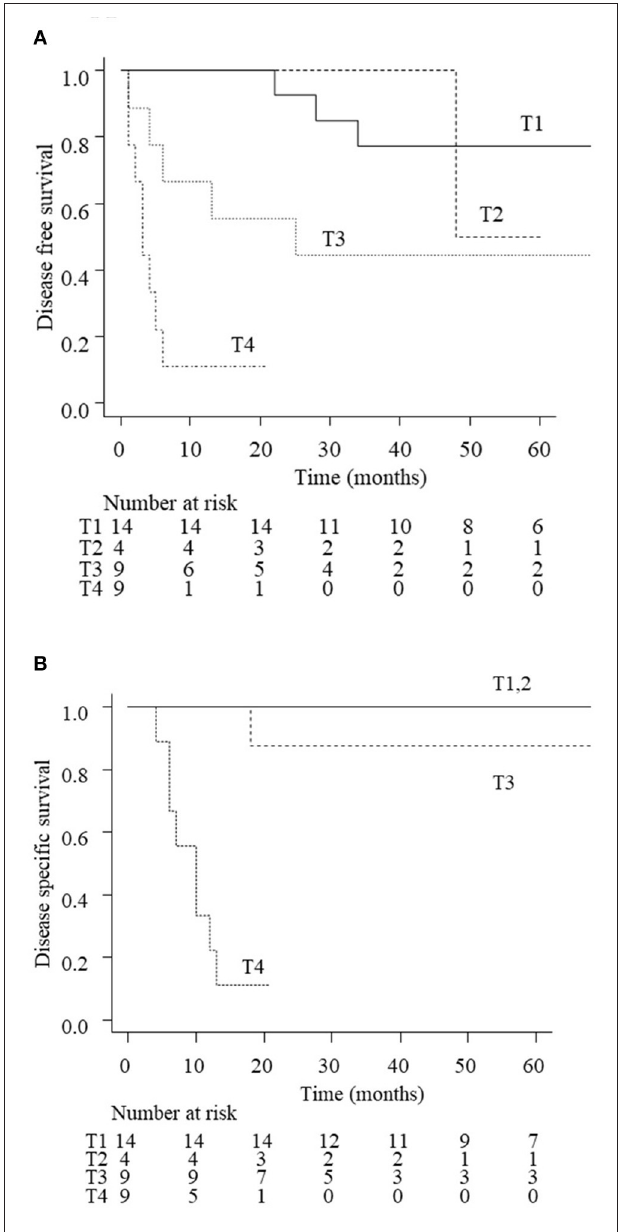
FIGURE 3 | Disease free survival (DFS; A ) and disease specific survival (DSS; B ) of T3 patients according to the treatments (LTBR vs. CCRT). The estimated 3-year DFS rates of T3 patients in the LTBR group and CCRT group were 80 and 0%, respectively ( p < 0.05). The estimated 3-year DSS rates of T3 patients in the LTBR group and CCRT group were 100 and 75%, respectively ( p = 0.317). LTBR, lateral temporal bone resection; CCRT, concurrent